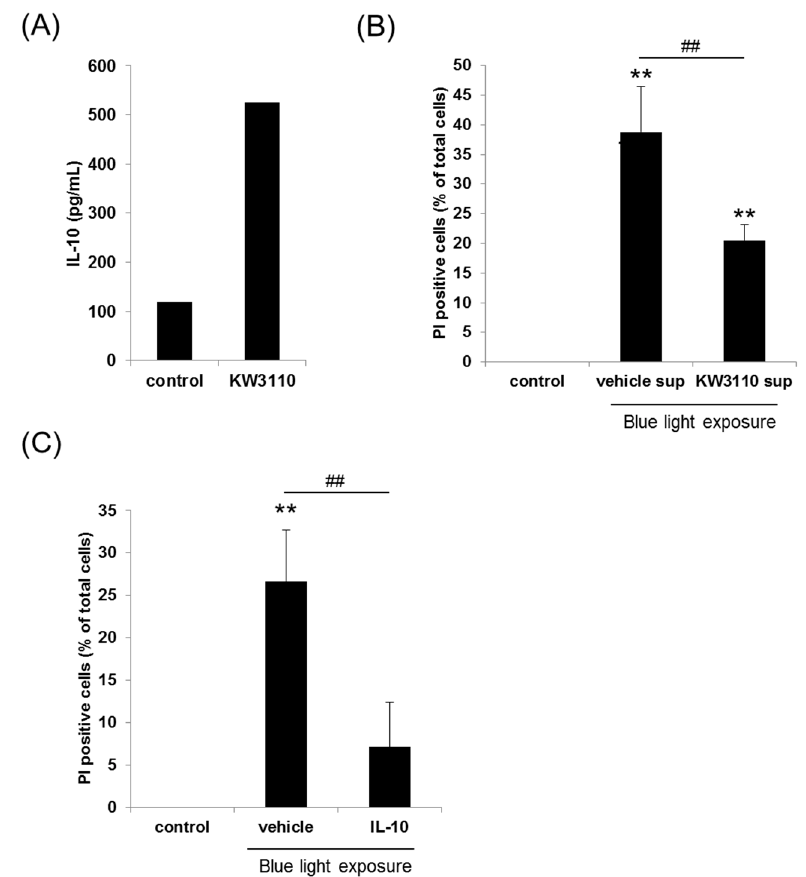
Figure 2. Effects of Lactobacillus paracasei KW3110 on cell viability under blue light exposure conditions. ( A ) Lactobacillus paracasei LW3110 activated human M2 macrophages. Human peripheral blood mononuclear cells (PBMC)-derived M2 macrophages were treated with 10 μ g/mL L. paracasei KW3110 or untreated (control) and cultured for 24 h. Interleukin 10 (IL-10) concentration of the culture medium was measured by ELISAs. ( B ) The inhibitory effect of L. paracasei KW3110-stimulated human PBMC-derived M2 macrophage supernatants (KW3110-sup) or vehicle-treated supernatants (vehicle sup) on blue light-induced retinal cell death in ARPE-19 cells as measured by propidium iodide (PI) staining. The number of cells exhibiting PI fluorescence was counted. PI positive cells were expressed as the ratio of PI-positive to Hoechst 33342-positive cells. Assays were performed in triplicate wells. The data shows the mean ± SD for triplicate wells. ** p < 0.01 versus control. ## p < 0.01 versus vehicle supernatants [one-way analysis of variance (ANOVA) followed by Tukey’s test]. ( C ) Inhibitory effects of IL-10 on blue light-induced retinal cell death in ARPE-19 cells. The number of cells exhibiting PI fluorescence was counted. PI-positive cells were expressed as the ratio of PI-positive to Hoechst 33342-positive cells. Assays were performed in quadruplicate wells. The data show the mean ± SD for triplicate wells. ** p < 0.01 versus the control. ## p < 0.01 versus the vehicle (one-way ANOVA followed by Tukey’s test). ELISA = enzyme-linked immunosorbent assay.